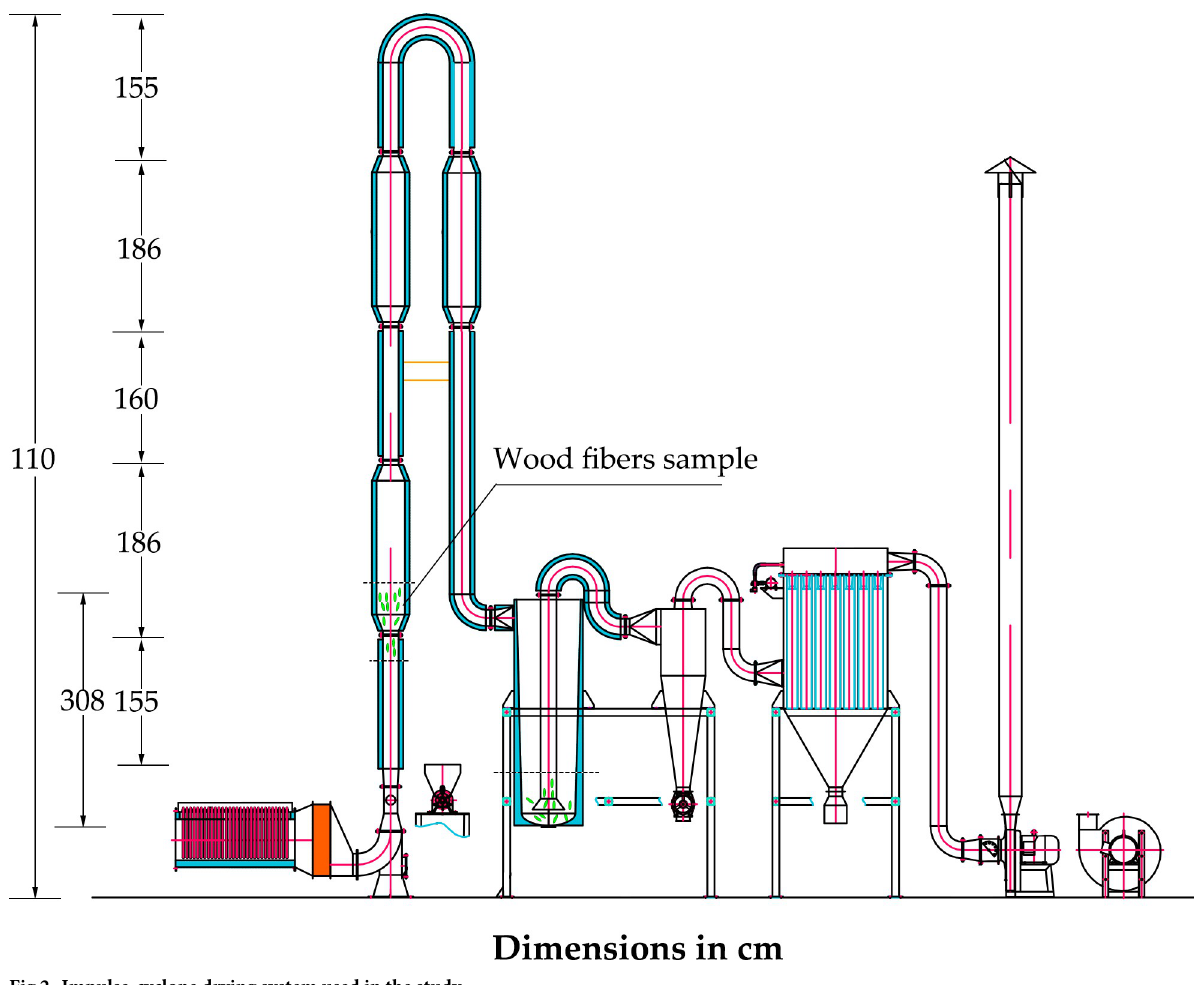
Fig 2. Impulse-cyclone drying system used in the study.